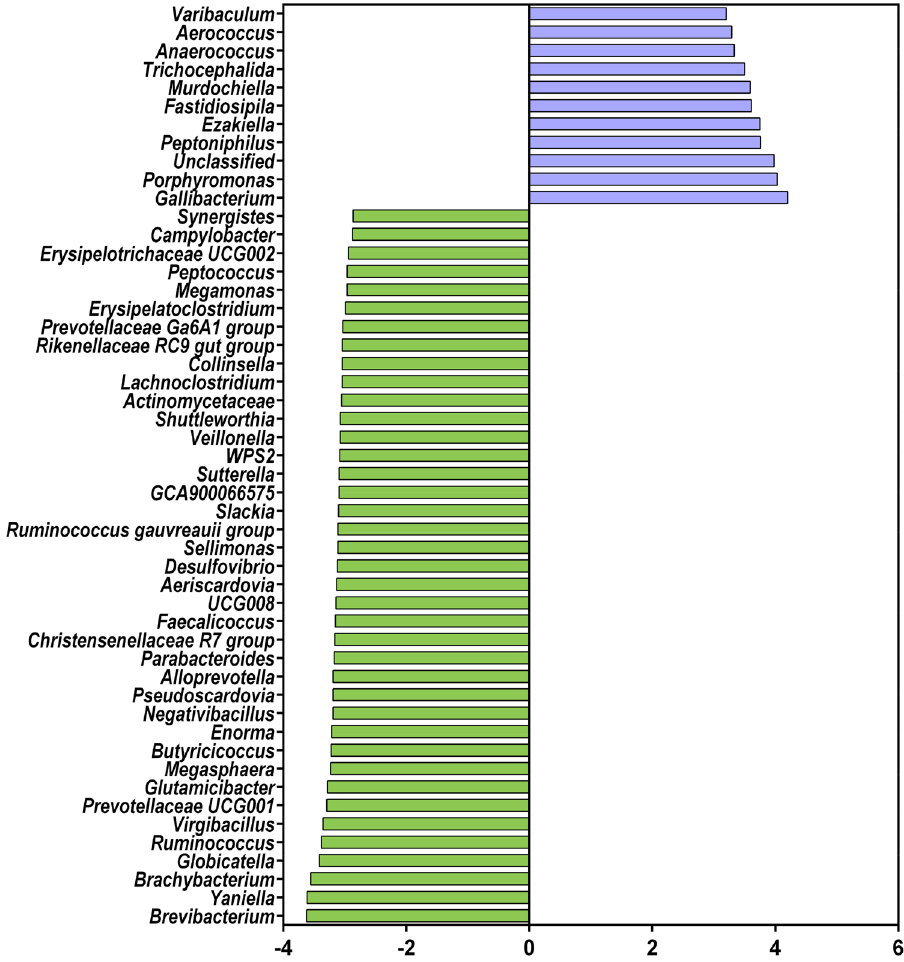
Figure 5. LefSe plot of genus level (SILVA taxonomy) differential